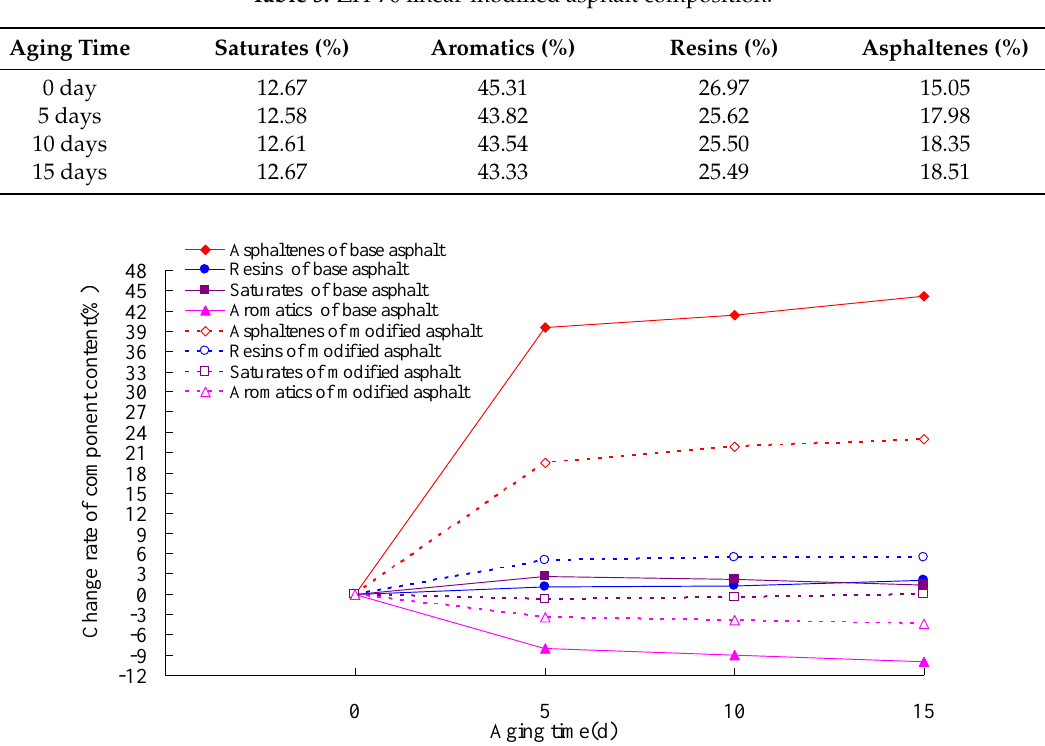
Table 5. ZH-70 linear-modified asphalt composition.